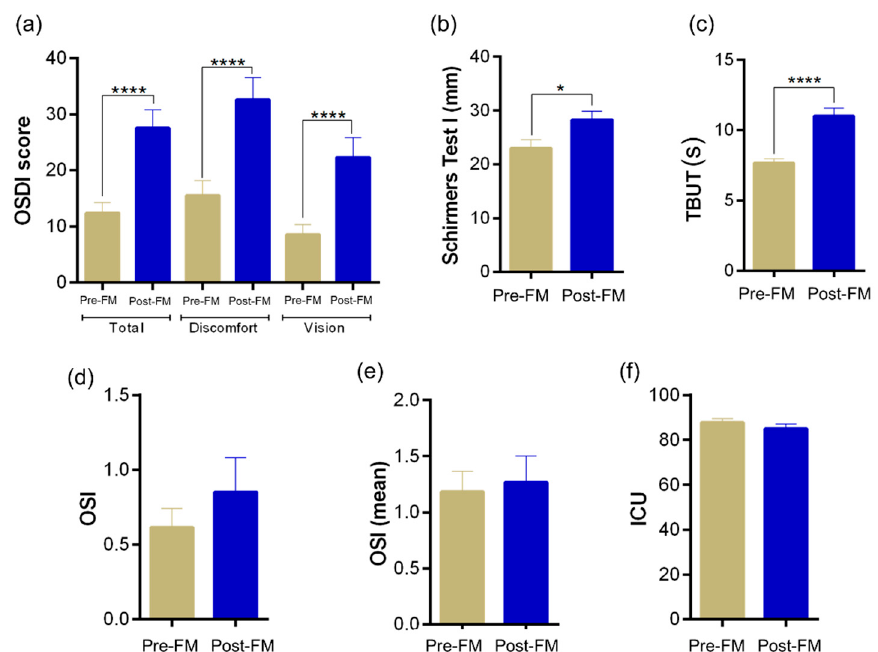
Figure 1. Status of ocular surface health indices in healthy individuals during the face-mask-wearing era. Bar graphs represent: ( a ) ocular surface disease index (OSDI) scores and ( b – f ) tear film quality assessments in matched study subjects prior to and during the face-mask-wearing era. ( b ) Schirmer’s test 1 values in mm/5 min, ( c ) tear breakup time—TBUT values in s ( d ) objective scatter index—OSI, ( e ) mean objective scatter index and ( f ) lipid layer thickness of the tear film quantified as interferometric colour units—ICU. N = 17; 34 eyes. Pre-FM indicates period where the study subjects were not wearing a face mask (pre COVID-19 era) for an extended period of time. Post-FM indicates period where the same study subjects were wearing a face mask (during the COVID-19 pandemic) for an extended period of time (approximately 8 hours a day). Bar graph indicates mean ± SEM. * p < 0.05, **** p < 0.0001, Wilcoxon matched-pairs signed rank test.